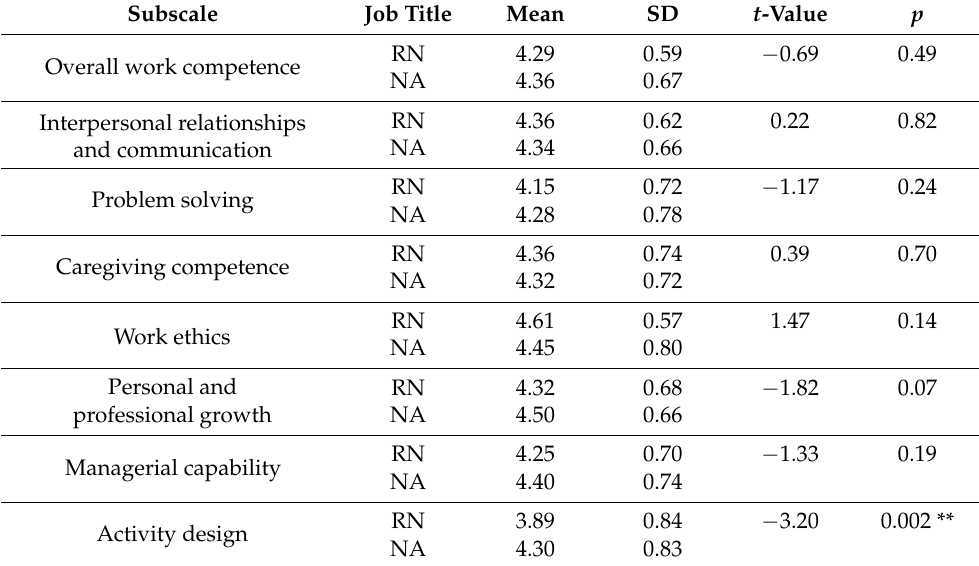
Table 5. Differences between registered nurses and nurse